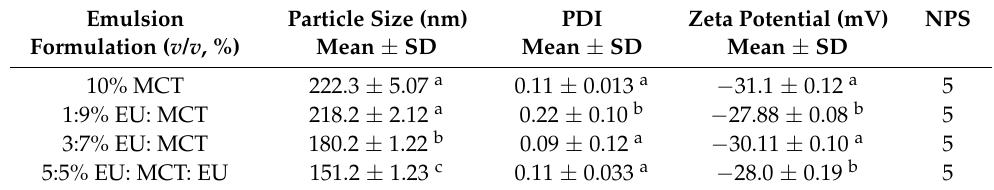
Table 1. Properties of oil in water nano-emulsions prepared with a medium chain triglyceride (MCT) oil phase, purity gum ultra as a surfactant, and 5:5% ( v / v ) mixed ratio of each with eugenol.